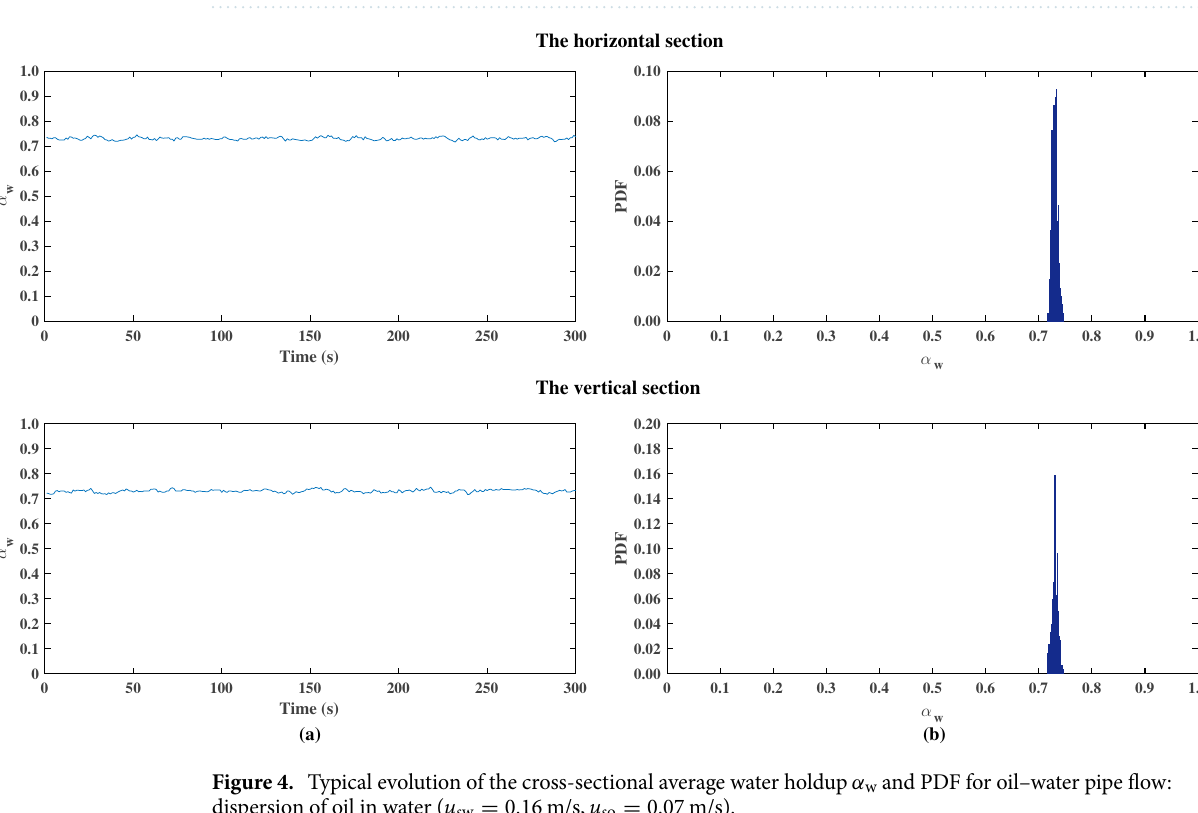
Figure 3. Instantaneous flow patterns observed in the experiments in the horizontal and vertical sections: ( a ) dispersion of oil in water, u s w = 0.16 m/s, u s o = 0.07 m/s; ( b ) dispersion of water in oil, u s w = 0.02 m/s, u s o = 0.20 m/s; ( c ) stratified flow, u s w = 0.40 m/s, u s o = 0.17 m/s.